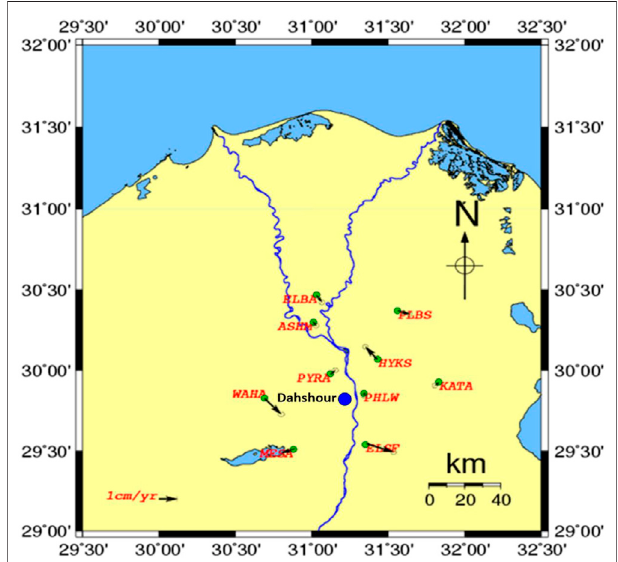
FIGURE 8 | Horizontal displacement rates of the study area from 2005 to